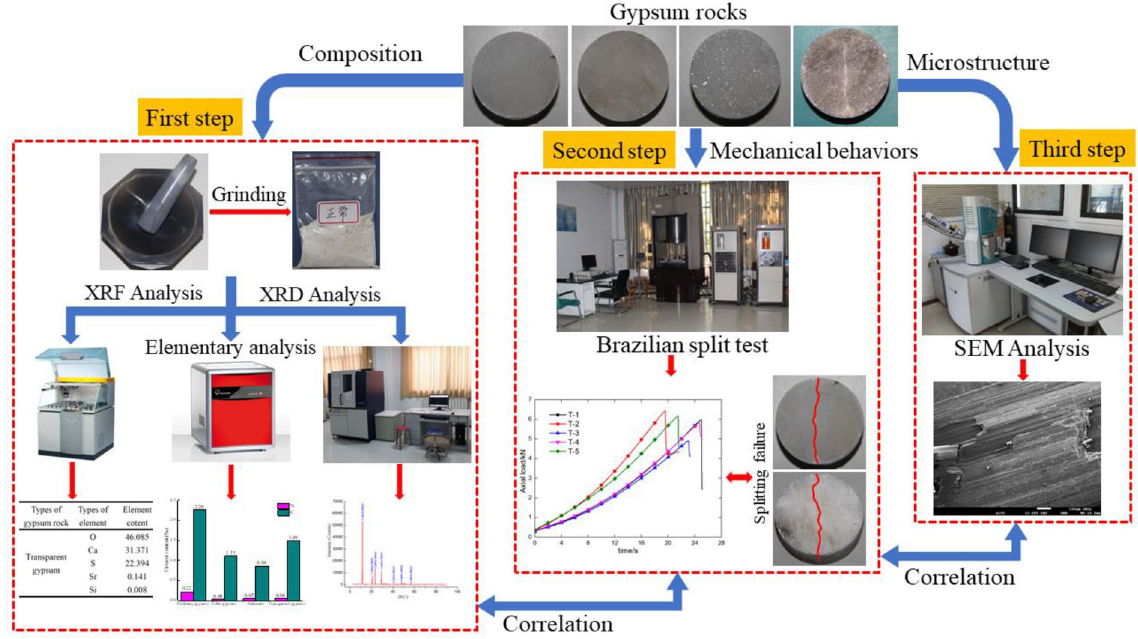
Figure 1. Experimental scheme of the tests for the characterization and the mechanical properties of gypsum rocks: X-ray fluorescence spectrometry (XRF), X-ray diffraction (XRD), Elemental analyzer, scanning electron microscopy (SEM), and Brazilian split test for the mineral composition, microstructure, and tensile strength of gypsum rocks, respectively. (The figure is just a screenshot which contains all the equipment and test pictures used in this paper, and is not generated by other